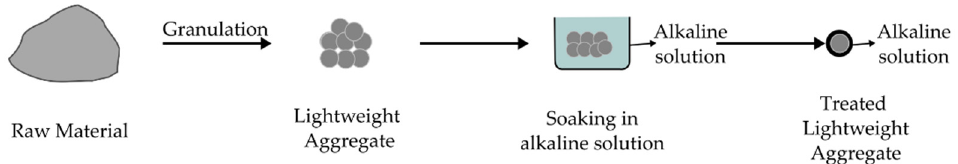
Figure 5. Soaking in alkali solution.